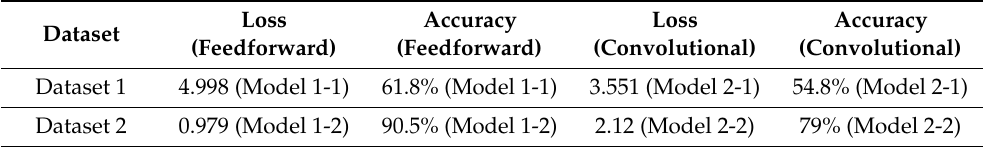
Table 3. Loss values and accuracies of